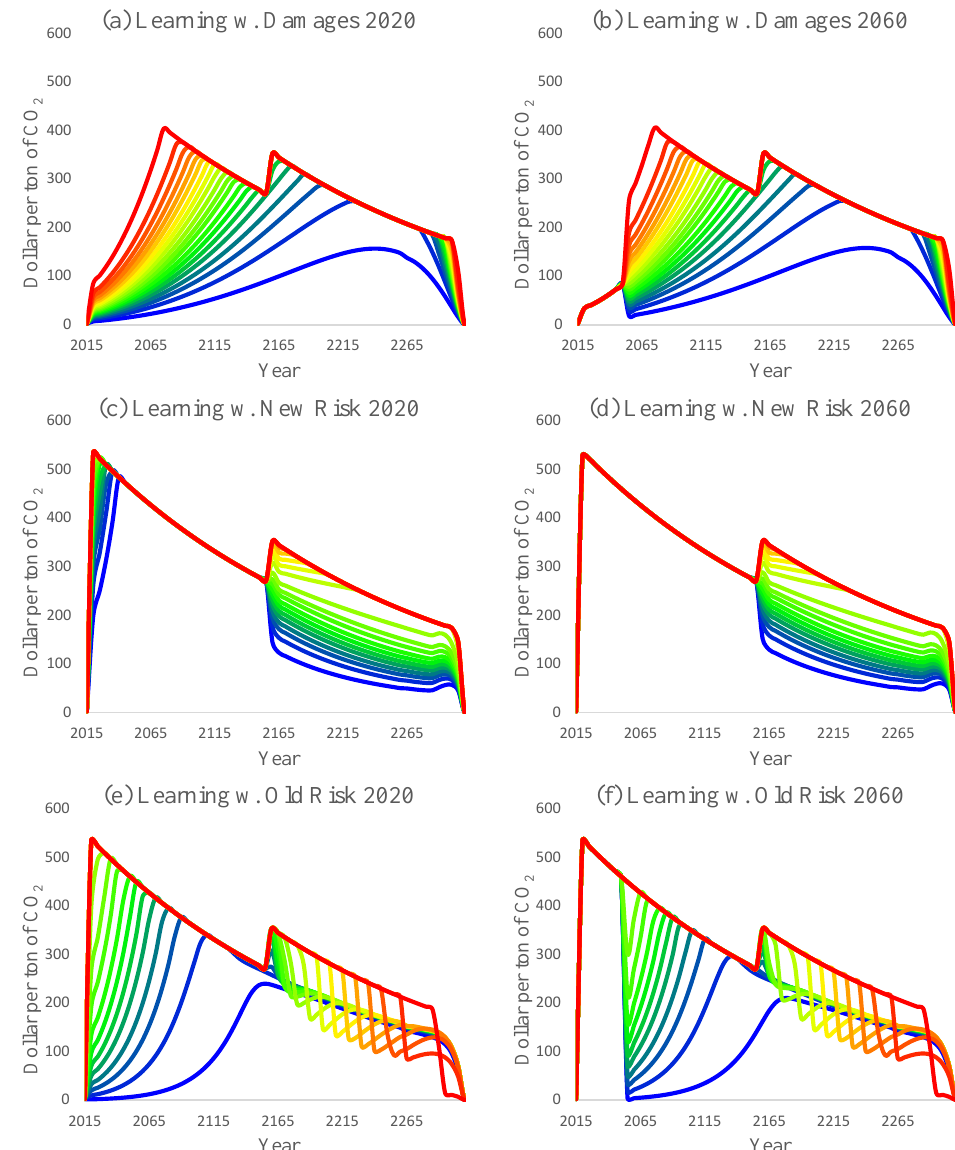
Figure 5. The carbon price paths in learning cases using damage function, new risk (New CRA, and old risk (Old CRA) scenarios. The colors show different states of the worlds ranging from dark blue for the lowest climate sensitivity to dark red for the highest climate